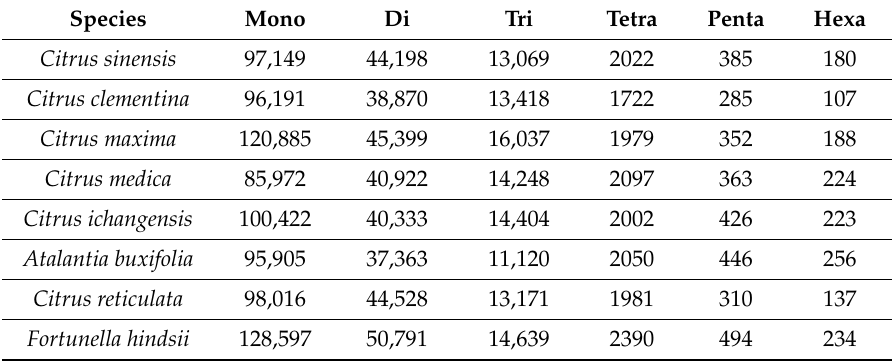
Table 4. Distribution of motif types in the designed SSR markers for each of the Citrus